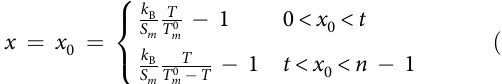
Here T 0 is the ultimate melting point of the polymer of in fi nite m length, S m is the melt entropy per CH 2 , and σ